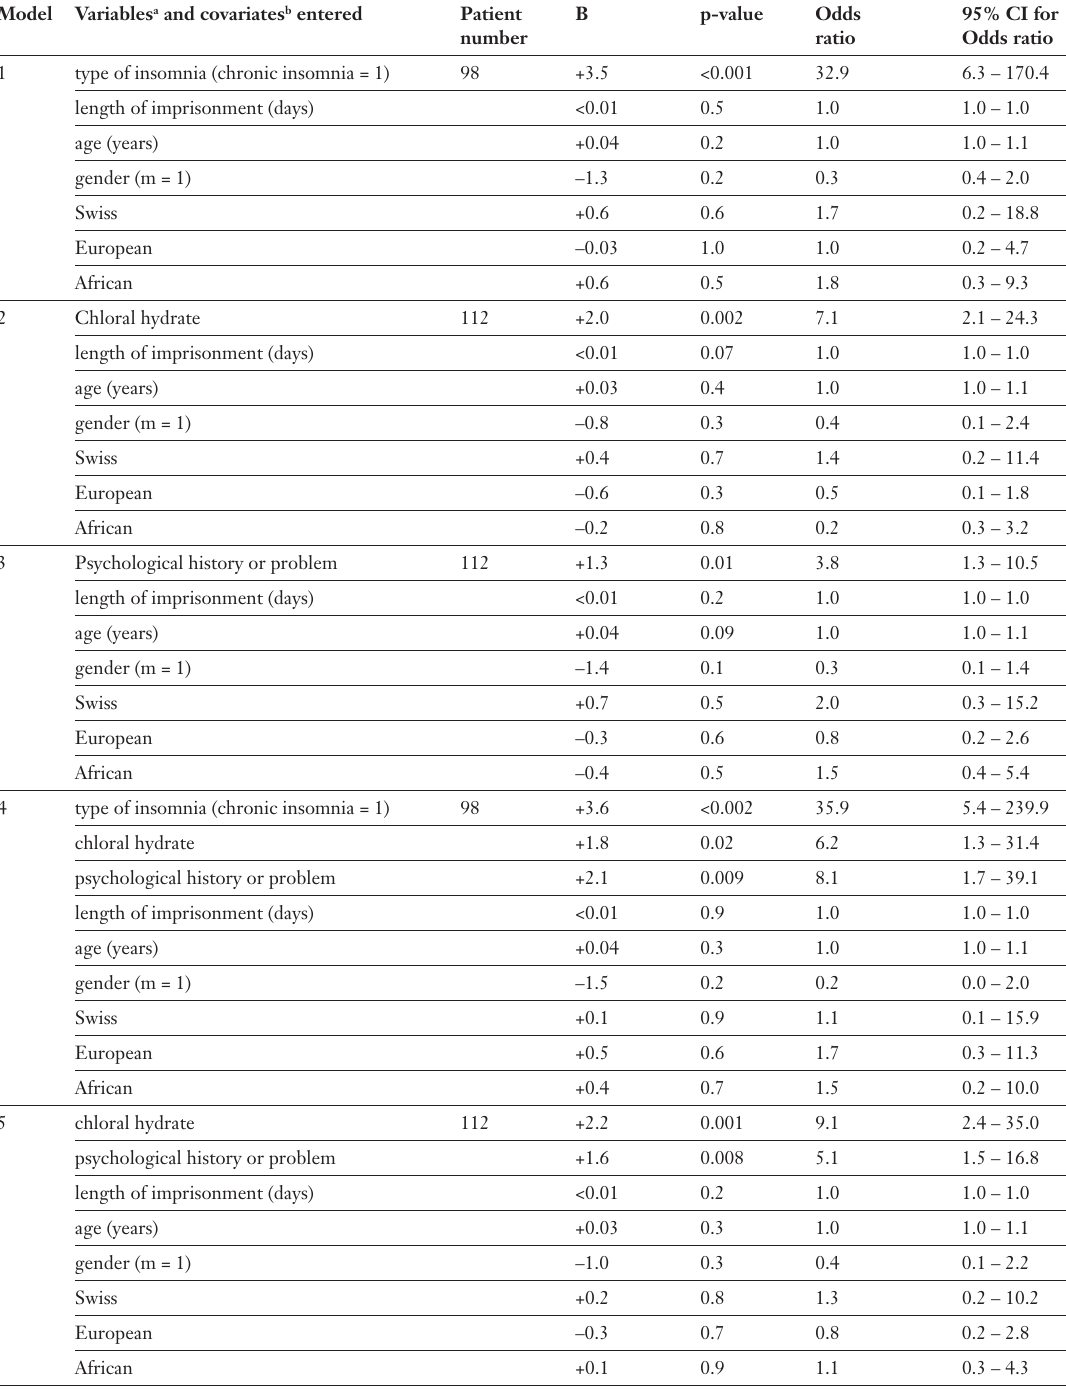
Binary logistic regression of the dependent variable “persisting insomnia problems”: partial or no improvement of insomnia (value = 1, n = 54) versus complete improve- ment of insomnia (value = 0, n =